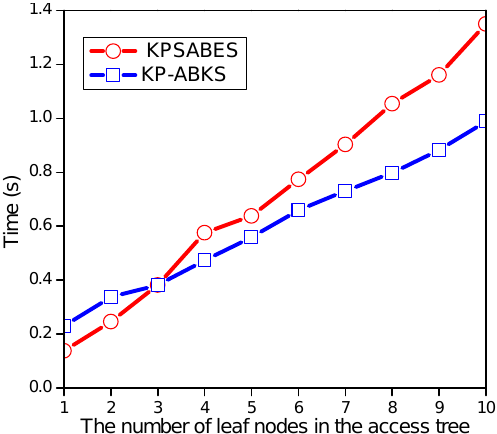
Figure 6. The time cost of Searchtoken algorithm in KPSABES and